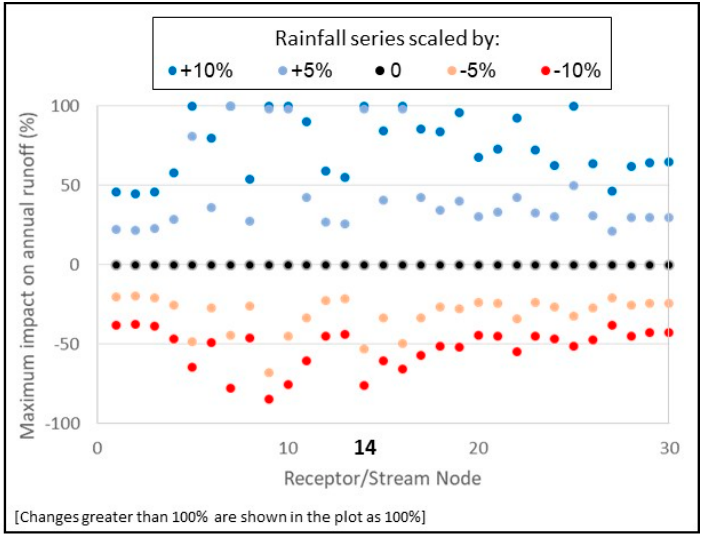
Figure 5. Maximum change on annual runoff from scaled changes in future rainfall.